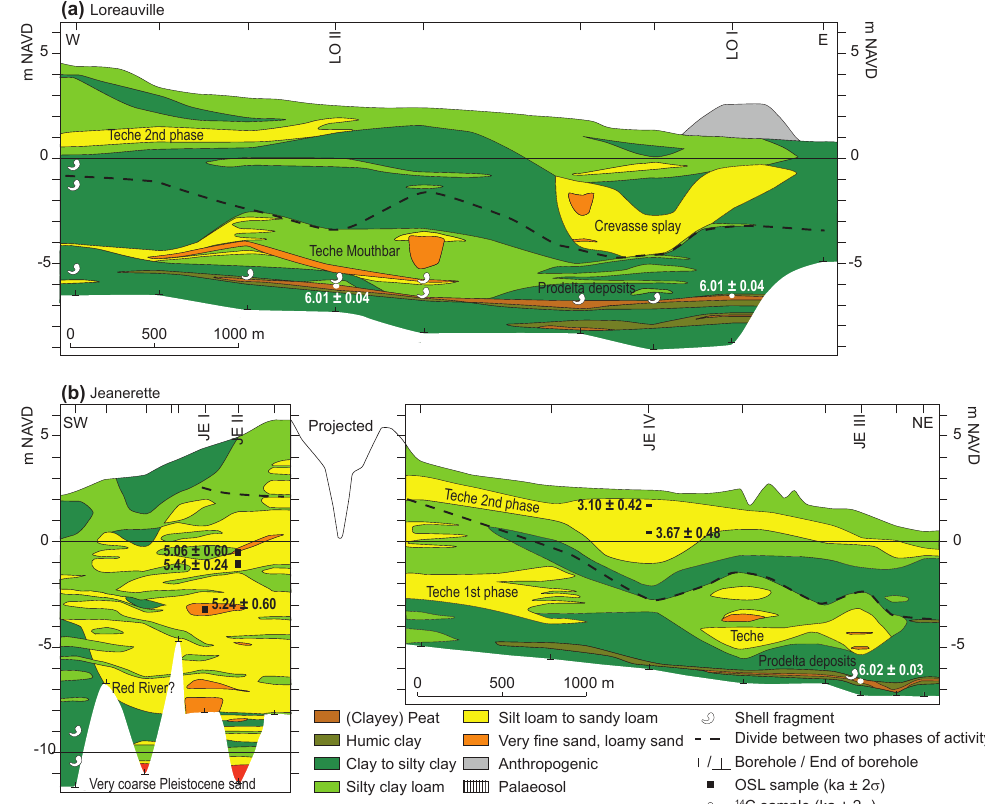
Figure 6. Cross sections (a) Loreauville and (b) Jeanerette with the stratigraphic position of the OSL (Table 1) and radiocarbon (Table 2)